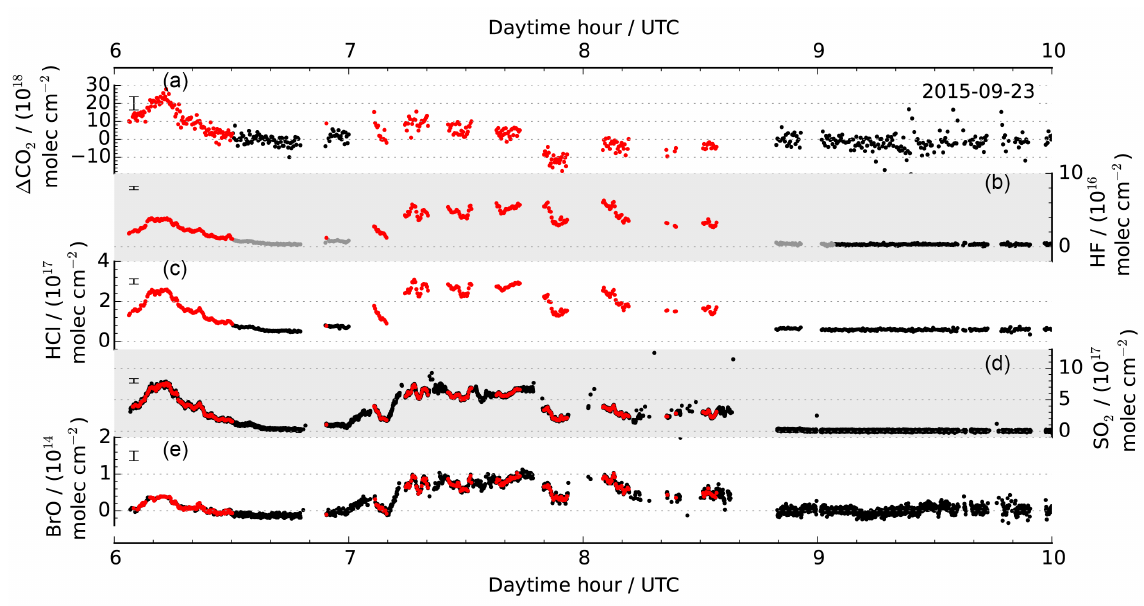
Figure 9. Same as Fig. 7 but for 23 September